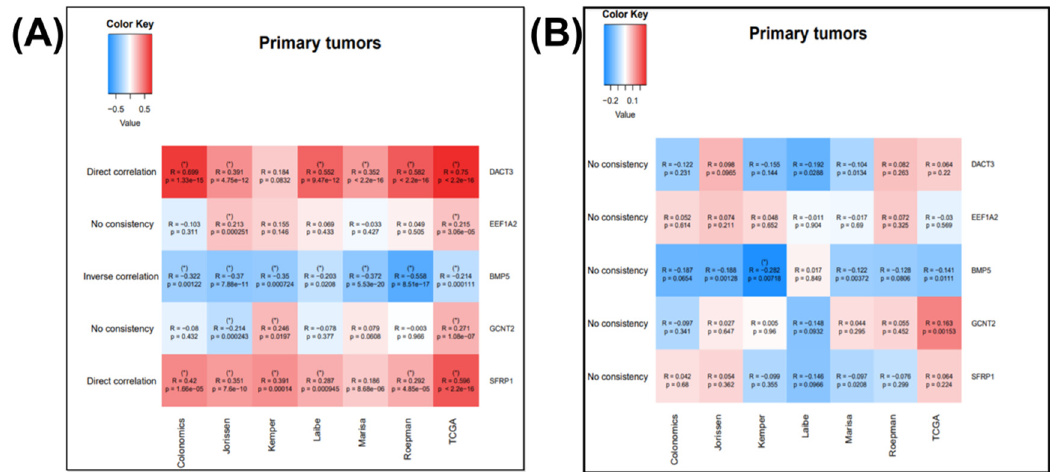
Figure 4. Correlation between the ( A ) NOX3 and EMT overexpressed genes, correlated with overall survival and ( B ) correlation between the IGF2BP3 and EMT overexpressed genes correlated with overall survival, generated using Cancertool (http://web.bioinformatics.cicbiogune.es/CANCERTOOL/, accessed on 22 April 2021) on five Affimetrix datasets (GSE44076, GSE14333, GSE33113, GSE37892, GSE39582), one Agilent dataset (GSE42284) and one RNAseq dataset. The color code shows the correlation status between the nominated gene pairs, red being toward 1 and blue toward − 1. (* p ≤ 0.05 and correlation coe ffi cient higher than 0.2 for direct and lower than − 0.2 for inverse correlations).